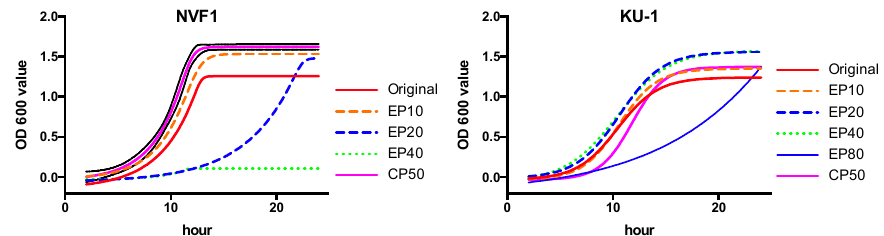
Figure 5. Growth of passaged variants in Chamberlain’s chemically defined medium (CDM) broth. Passaged variants of NVF1 and KU-1 strains were cultured in CDM broth and the optical density (OD) at 600 nm observed for 24 h. Interpolated growth curves were prepared by Graphpad Prism 6.0c. Variants passaged on Eugon chocolate agar 10, 20, 40, and 80 times [EP10, EP20, EP40, and EP80 (for KU-1), respectively] and variant passaged on CDM based agar plate 50 times (CP50) inoculated. NVF1 EP40 failing to grow over 24 h whereas KU-1 variants were attenuated at later passage numbers, with poor growth of EP80 over 24 h.